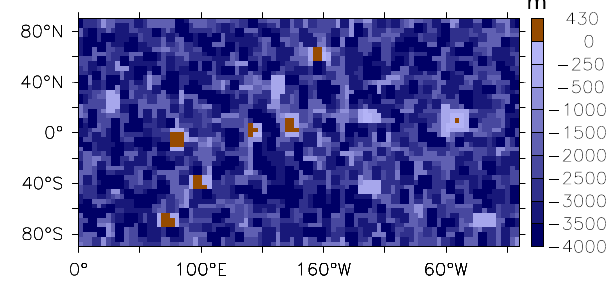
Fig. 4: Early Archean topography used in this study. This specific ocean depth field is created Fig. 4. Early Archean topography used in this study. This specific Fig. 3. Pre-industrial SAT profile for standard model equilibrium ocean depth field is created randomly but respects an area-per-depth randomly but respects an area-per-depth distribution based on geological modelling and exhibits an and the version with implementation of technical changes required distribution based on geological modelling and exhibits an emerged emerged surface area of 1 % . [Continents with positive topography] for applying Archean boundary conditions later on. surface area of The area-per-depth distribution is based on a geological modelling study by Flament et al. (2008) assuming a 200 K hotter mantle as well as 20 % continental crust compared to today’s value. The 265